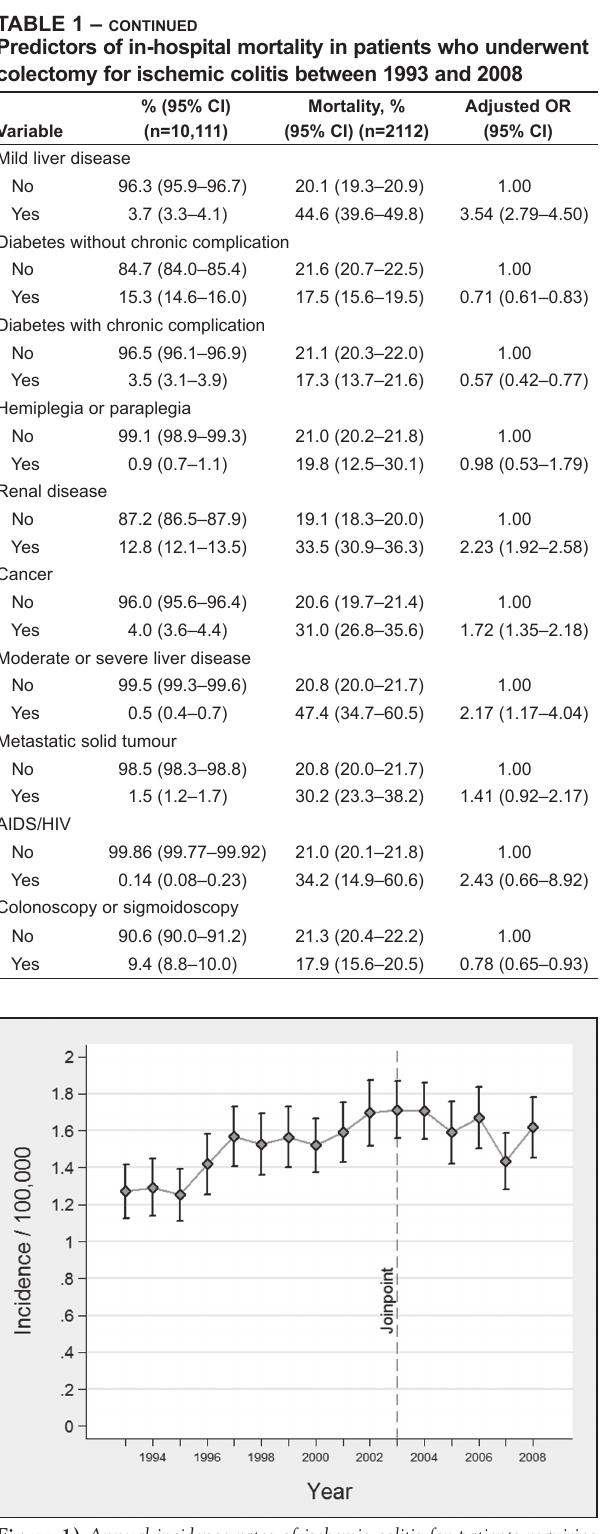
Figure 1) Annual incidence rates of ischemic colitis for patients requiring